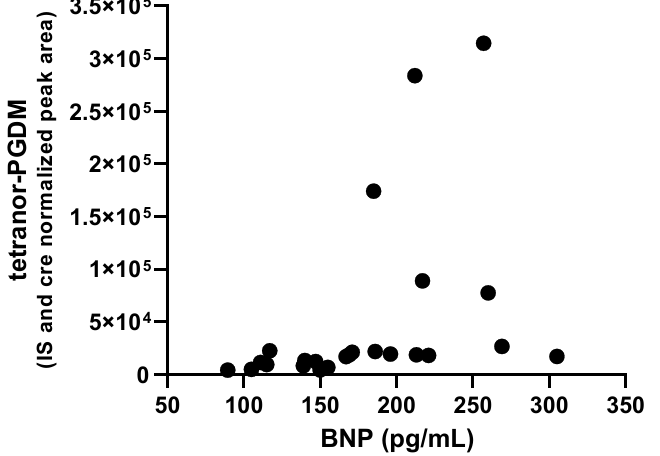
Figure 2. Correlation between BNP and urinary tetranor-PGDM level (r = 0.7052). Data on four time points of six patients were plotted.